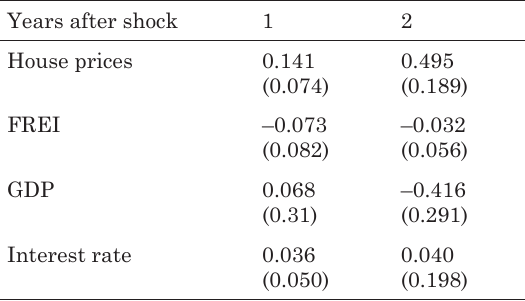
Table 4. responses to a construction cost